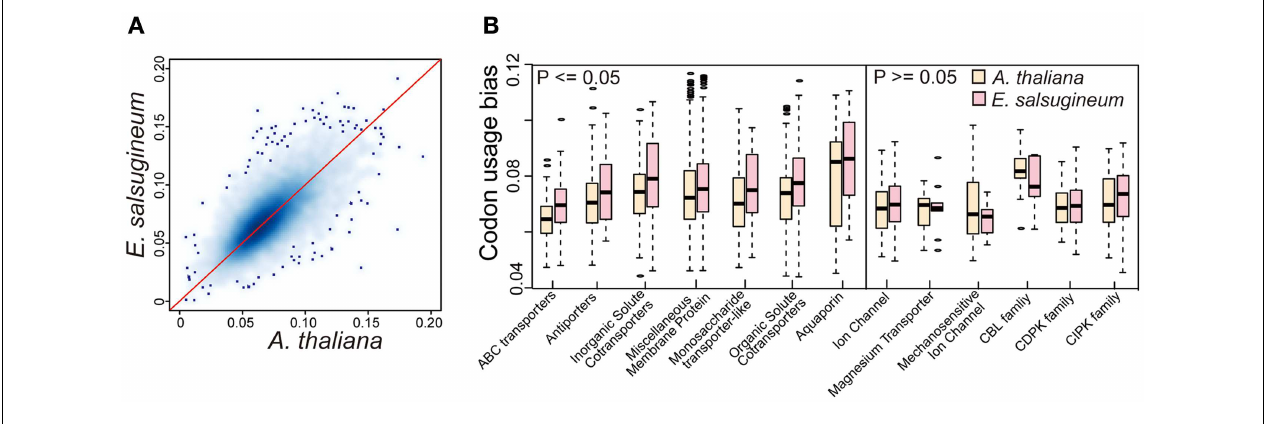
E. salsugineum .The x- and y-axis denote the tAI coefficient of genes. (B) Comparison of codon usage bias (tAI) of genes in terms of functional categories.